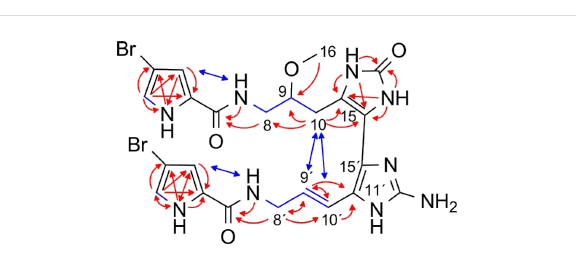
Figure 5: Selected 1 H, 1 H-COSY (blue bonds), 1 H, 1 H-NOESY (blue arrows), 1 H, 13 C-HMBC, and 1 H, 15 N-HMBC (both red arrows) correla- tions for citrinamine D ( 4